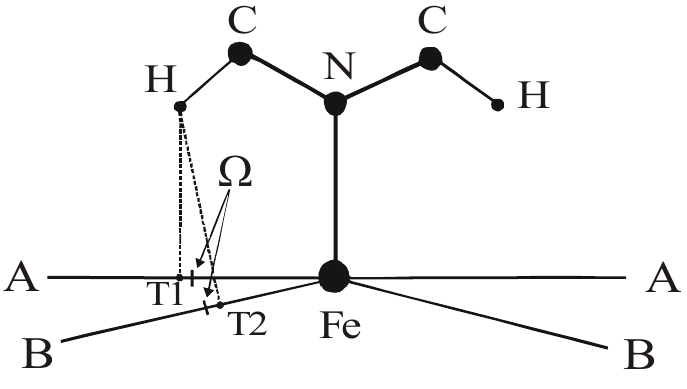
Figure 8. Schematic representation of C − H ⋅⋅⋅π interactions with chelate ring of porphyrin in case of planar (A) and ruffled porphyrin (B). Only part of pyridine is presented. Porphyrin is presented as a line. In both cases projection of the hydrogen atom to the plane of chelate ring (T1 and T2) is close to the center of the ring ( Ω ). In case of ruffled porphyrin H ··· Ω distance is